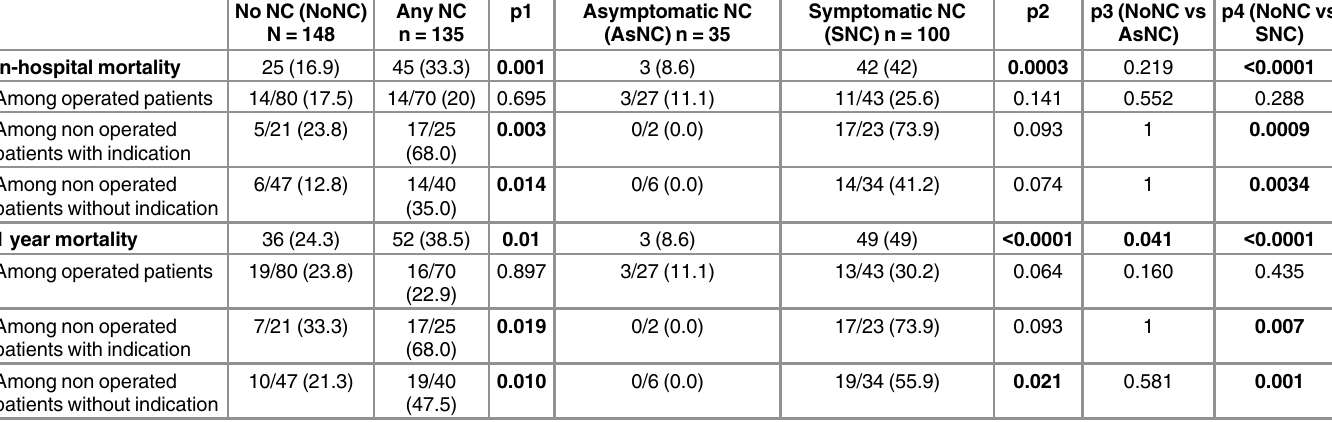
Table 4. Comparison of mortality among patients according to the absence or the presence of neurological complications (NC) either asymptom- atic or